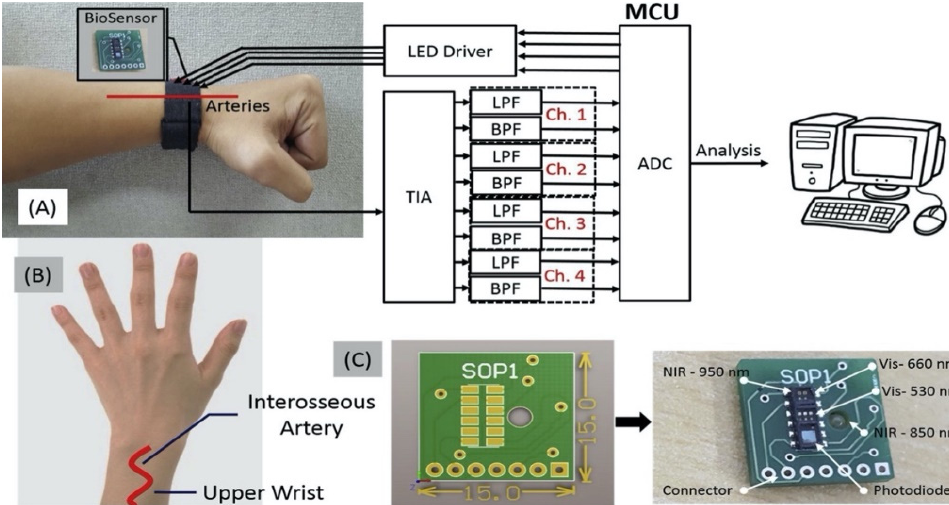
Figure 3. A wearable glucose sensor system: ( A ) signal processing block diagram, ( B ) measurement site, and ( C ) designed printed circuit board with four photodiodes biosensor. Reprinted with permission from [23].